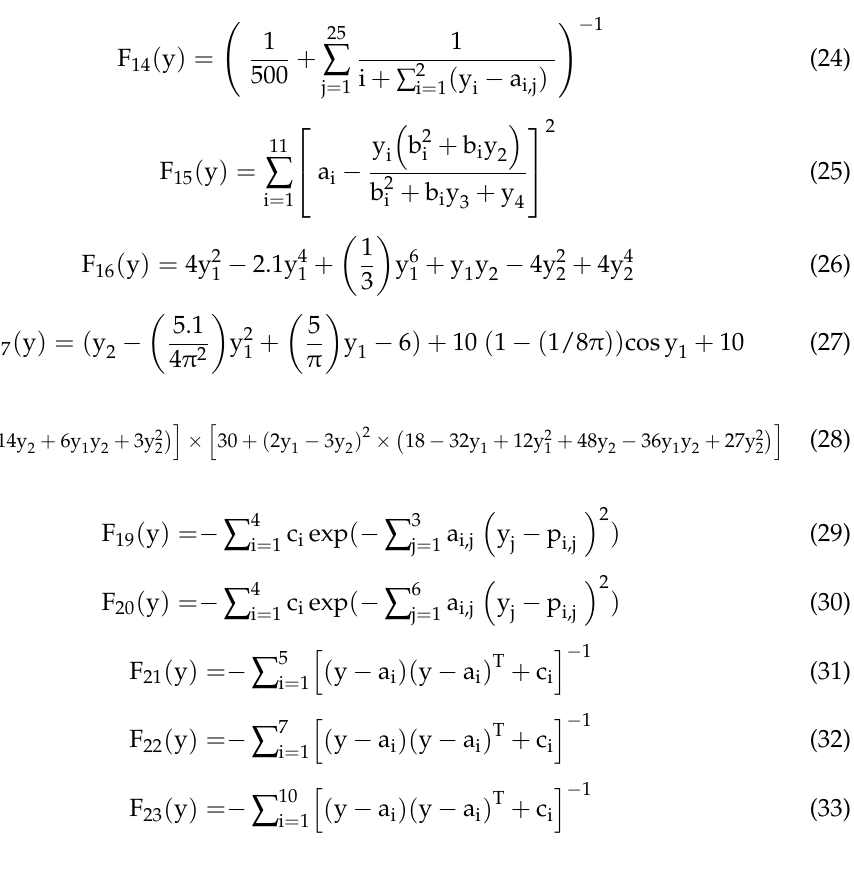
Table 1. Benchmark function